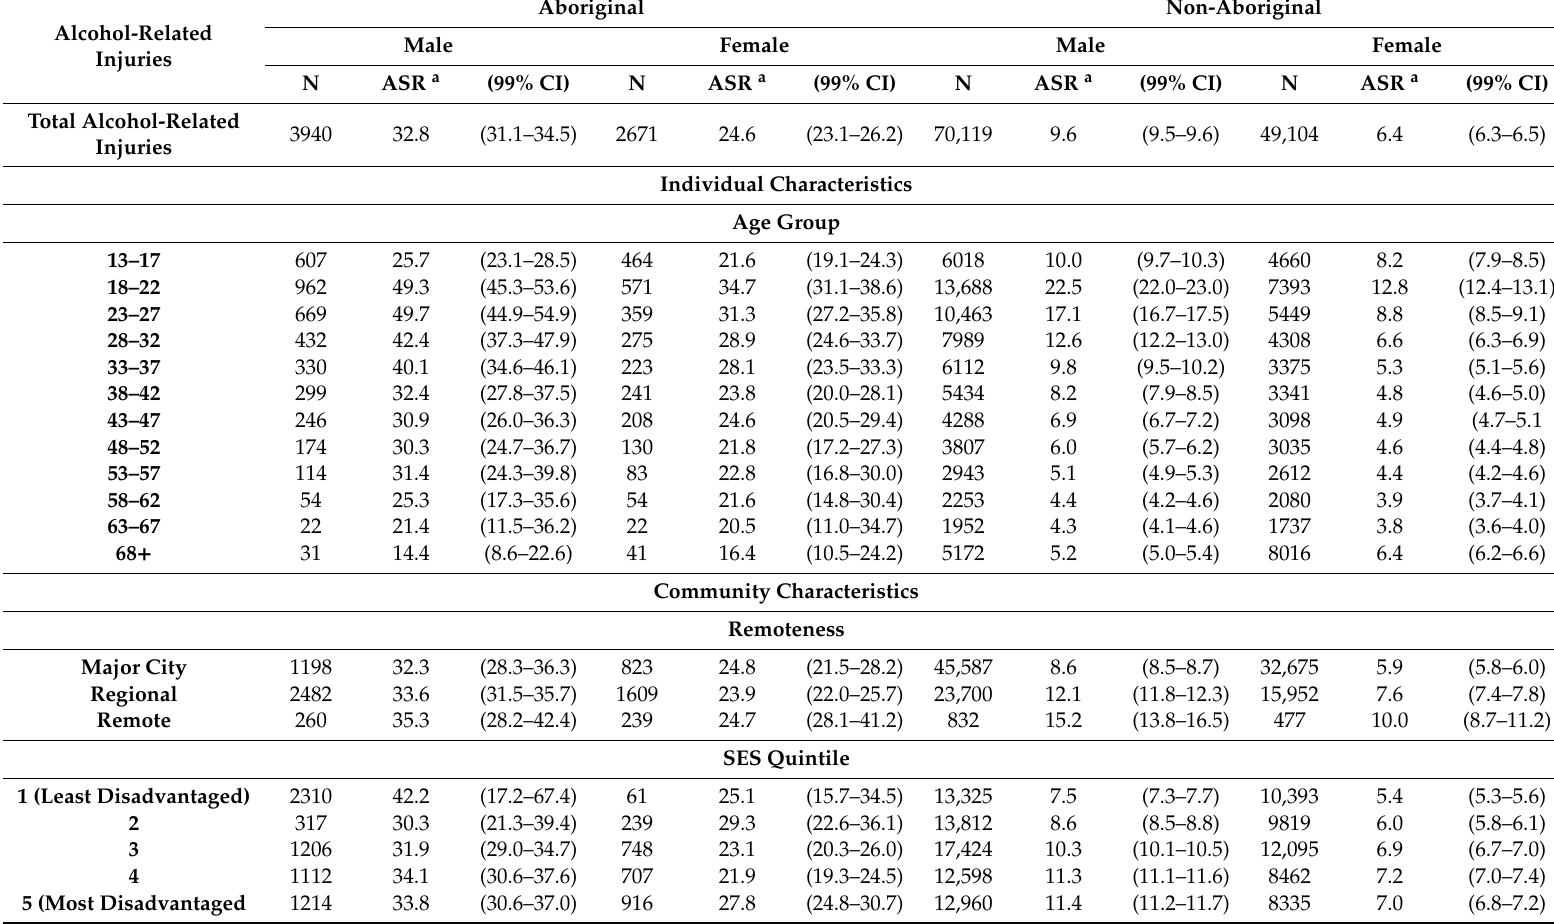
Table 1. Total number and age-standardised rates of alcohol-related injuries in New South Wales (NSW) between 1 January 2012 and 31 December 2014, by Aboriginal status and